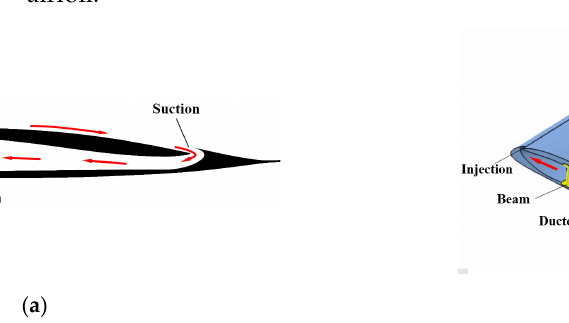
Figure 1. Schematic diagrams of CFJ principle. ( a ) Front view; ( b ) isometric view.